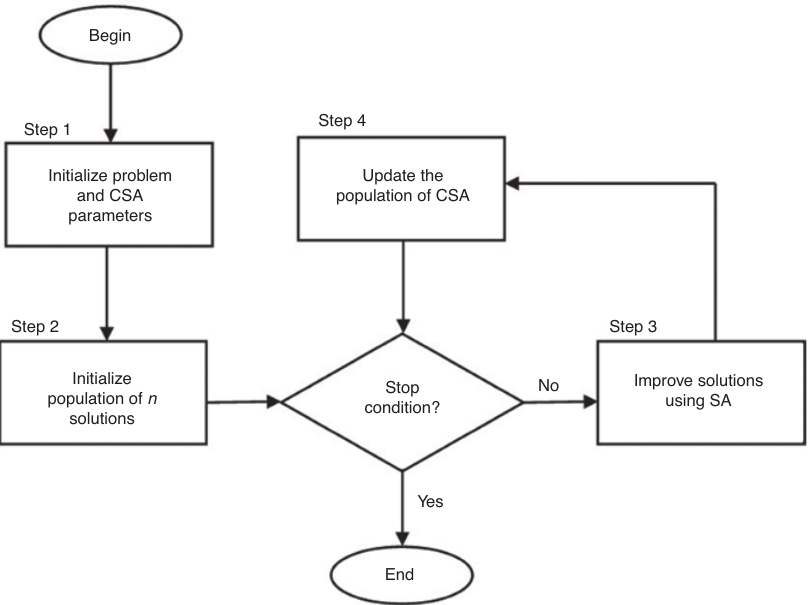
Figure 5: Flow Chart of Hybrid CSA